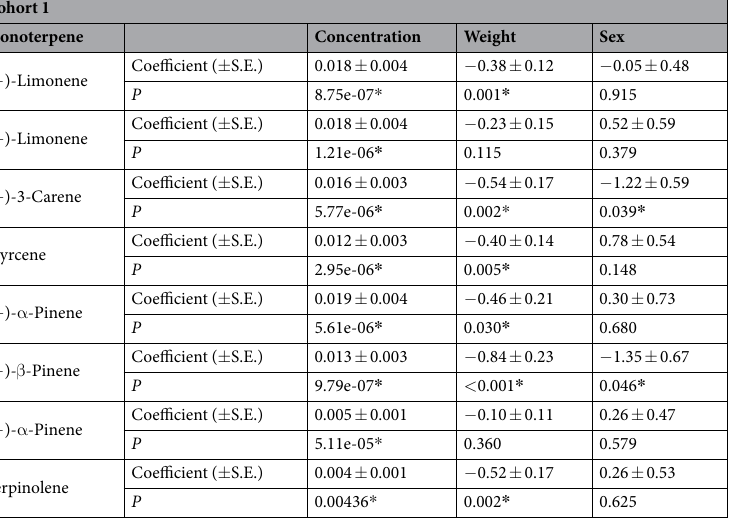
Table 3. The independent effects of concentration, body weight and sex on mortality for each monoterpene tested with MPB from cohort 1. Logistic regression analysis was used to assess the effects of monoterpene concentration, body weight, and sex on mortality for each of the monoterpenes tested. The coefficient indicates the magnitude and direction of each of these effects on mortality. Concentration: A positive coefficient indicates a positive relationship between increasing concentration and mortality. A significant positive coefficient was found for all monoterpenes tested indicating increasing toxicity at increasing concentrations. Weight: A positive coefficient indicates a positive relationship between increasing weight and mortality. Most monoterpenes had a significant negative coefficient, indicating heavier beetles survived more often. Sex: A positive coefficient indicates females survived more often than males. A negative coefficient indicates males survived more often than females. Most monoterpenes did not show a significant coefficient indicating that sex did not influence survival. * Denotes P -value <